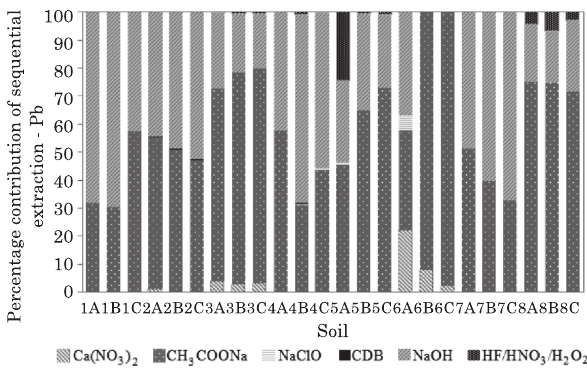
Figure 2. Percentage contribution of total Pb concentrations in sequential extractions calculated considering the control of mass loss of the soil samples. Sequential extractions, with total dissolution of each phase after exchangeable [(Ca(NO 3 ) 2 ] treatment: carbonates (sodium acetate - CH 3 COONa); organic matter (sodium hypochlorite - NaClO); amorphous and crystalline Fe oxides (dithionite-citrate-bicarbonate - DCB); Al oxides, aluminosilicate of low crystallinity